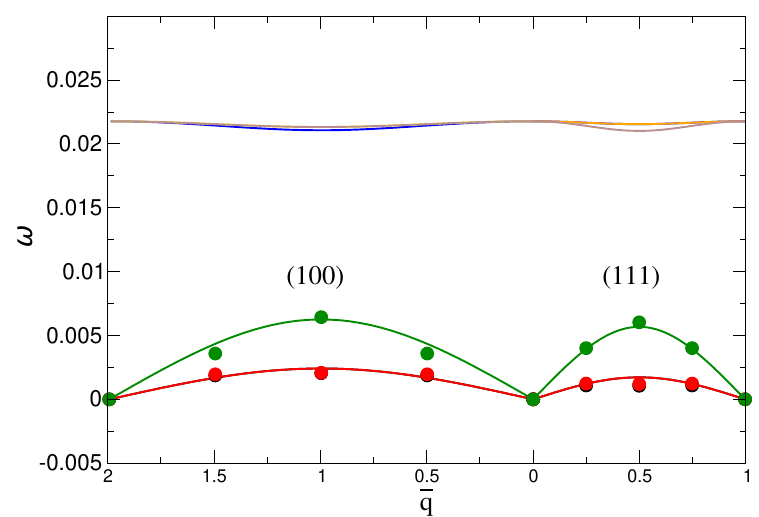
Figure 5. The dispersion relation obtained from simulation and fit with theory [51] for the (100) and (111) directions. The points are the values calculated from MD simulation based on the eigenvalues of the dynamical matrix (Equation (8)). The solid line is the fit with the dispersion form given in ref. [51]. These data are for the system with DNA stiffness of k a = 1.0 and NP size d = 40 σ . ¯ q = qb /2 π is the reduced wave vector and b is the lattice